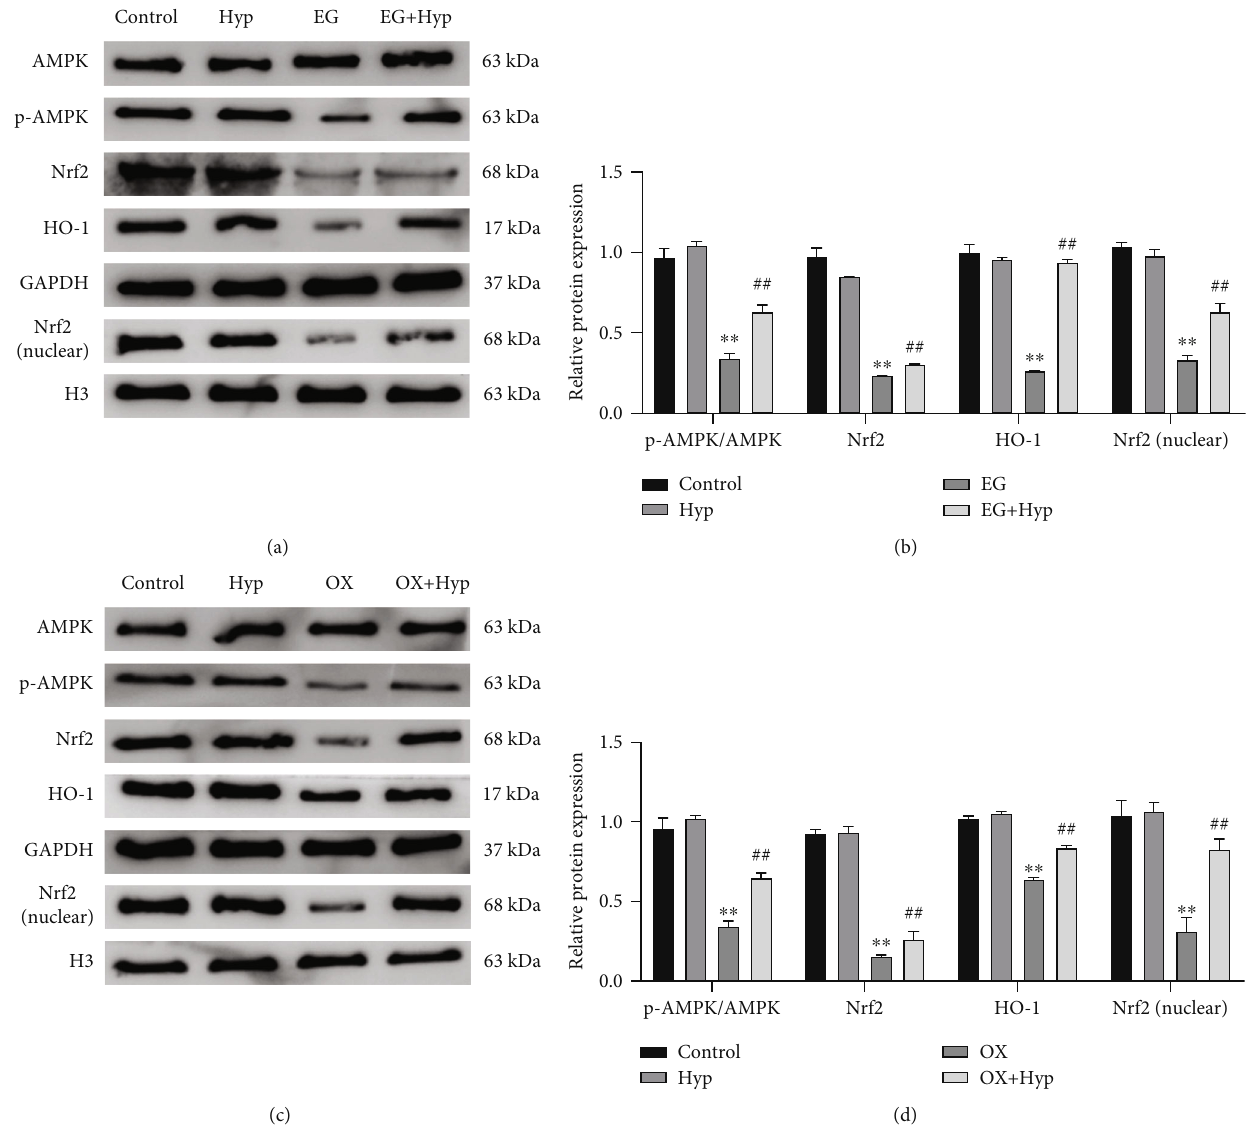
Figure 6: E ff ect of hyperoside on AMPK/Nrf2 signaling pathway in kidney tissue of nephrolithiasis rats and in HK-2 cells treated with calcium oxalate. (a – d) Western blot and quantitative analyses for the protein expression levels of AMPK, p-AMPK, Nrf2, HO-1, and nuclear Nrf2 in the kidney tissues of rats (a, b) and in HK-2 cells treated with CaOx (c, d). ∗∗ P < 0 : 01 vs. control group and ## P < 0 : 01 vs. EG group or OX